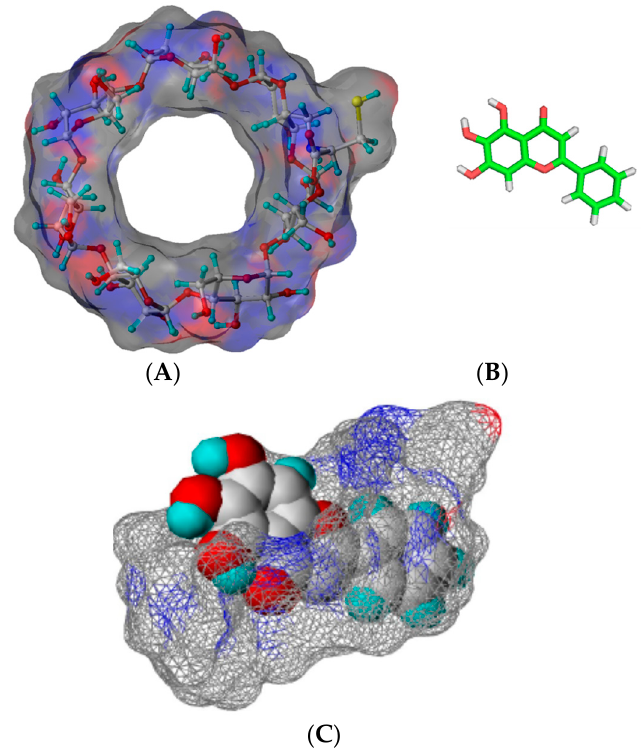
Figure 3. Structures of cysteinyl β -CD ( A ) and baicalein ( B ). The proposed mode of complex ( C ) [24].